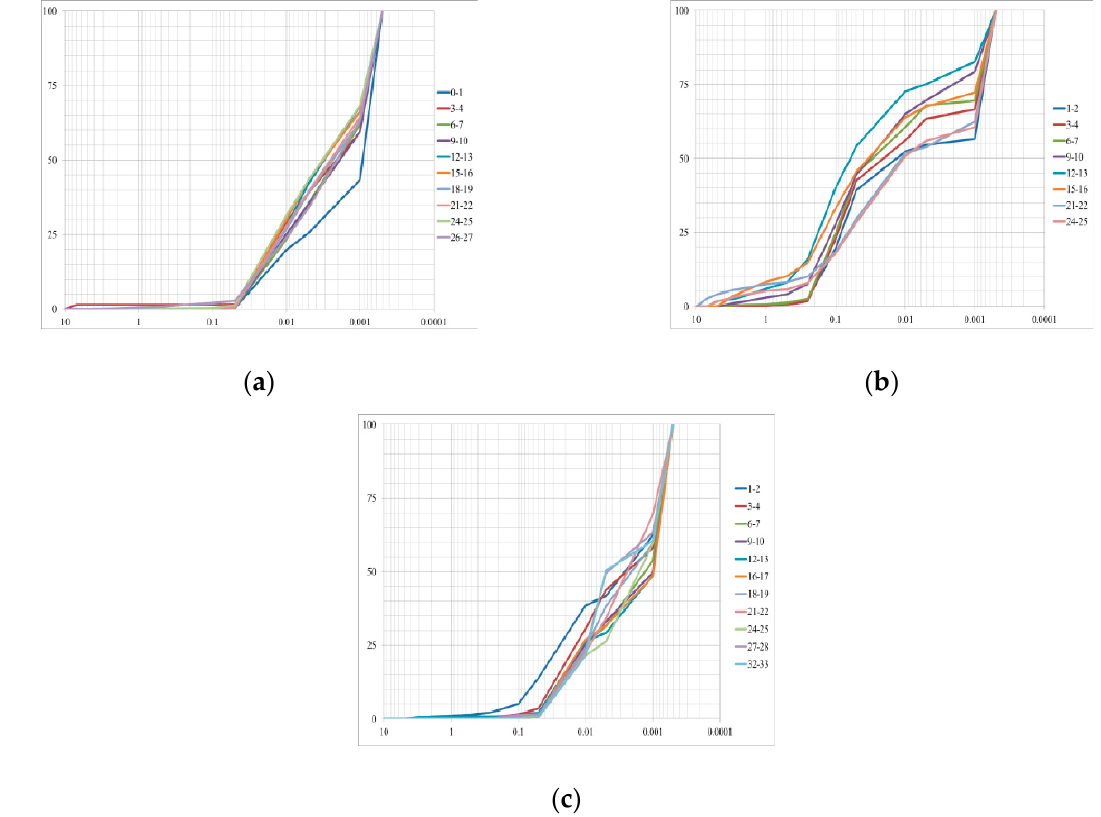
Figure 3. Percentage of grain size fractions (10–0.0001 mm) in sediment cores: ( a ) AMK-5424, the Russkaya Gavan’ Bay, the northwestern coast of the Novaya Zemlya Archipelago; ( b ) AMK-5432, the Bear Island Trough; and, ( c ) AMK-5454, the Cambridge Strait, the Franz Josef Land. Different colors indicate sampling depths (cm).